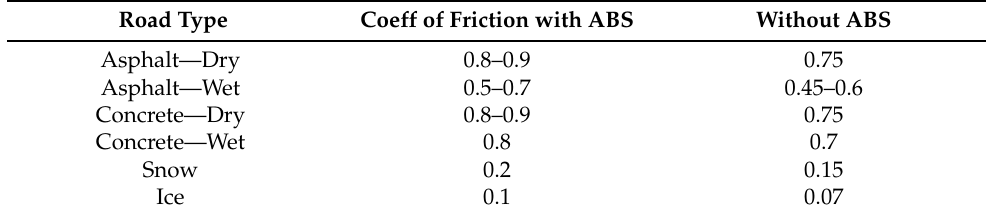
Table 1. Coefficient of